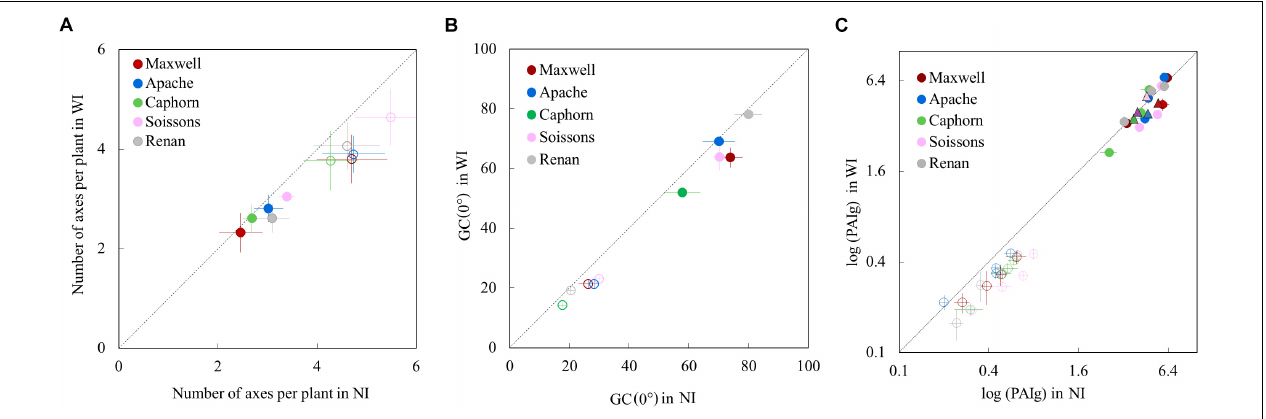
FIGURE 3 | The number of axes per plant (A) , the vertical ground cover GC(0 ◦ ) (B) , and the green plant area index PAIg (C) , in WI treatments vs. NI treatments. Each color is associated with a cultivar, as indicated in the legend. Error bars represent the 95% confidence intervals of mean estimates and the dotted line represents the line 1:1. In (A) , each symbol represents the mean value of the number of axes measured for 20–30 plants per treatment. Empty symbols are for end of tillering ( ∼ 870 ◦ Cd) and full symbols are for flowering. In (B) , each symbol shows the mean value of GC(0) from analyzing six photographs covering each an area of 0.73 m 2 . Empty symbols represent measurements at 682 ◦ Cd (LS = 5.6) and full symbols represent measurements at 1565 ◦ Cd (after flag ligulation). In (C) , circles show the PAIg estimated from oblique photographs: estimates at early stages are shown with empty circles (520 ◦ Cd, 532 ◦ Cd, 657 ◦ Cd, and 683 ◦ Cd) and estimates at later stages are shown with full circles (952 ◦ Cd, 1222 ◦ Cd, and 1555 ◦ Cd). Each circle shows the mean of values calculated from analyzing three photographs covering each area of 2.03 m 2 . Triangles represent the PAIg measured at flowering (1575 ◦ Cd) from scans of leaves and stems. TABLE 1 | The mean values of grain yield and ear number per plant for the 10 treatments. Maxwell Apache Caphorn Soissons Renan NI